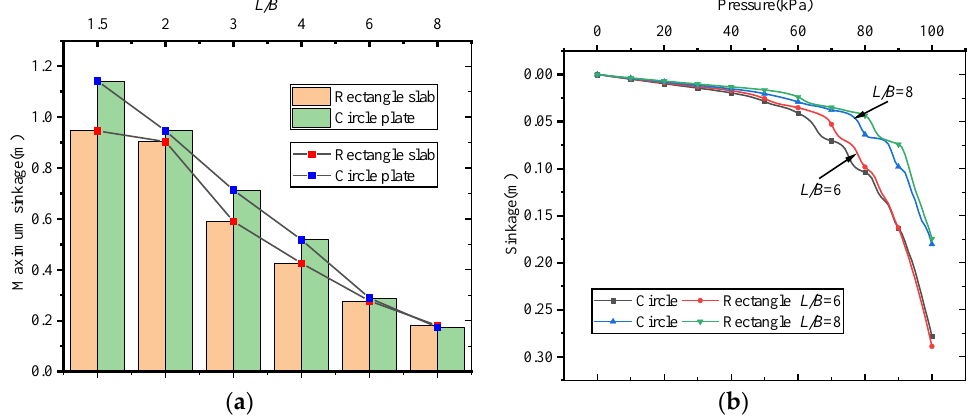
Figure 20. ( a ) Comparison of maximum displacements under different L/B ratios and ( b ) pressure- sinkage curves when L/B = 6 and 8.